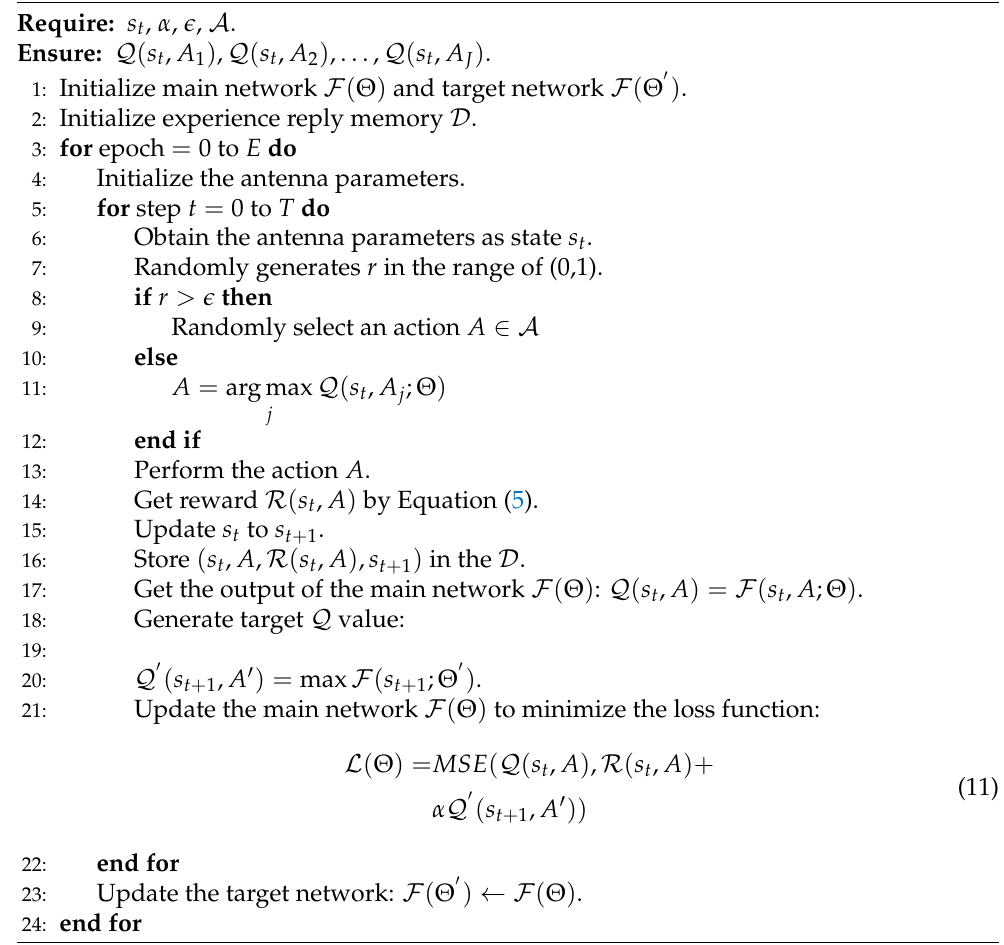
Algorithm 2 DQN-based method for HAPS antenna